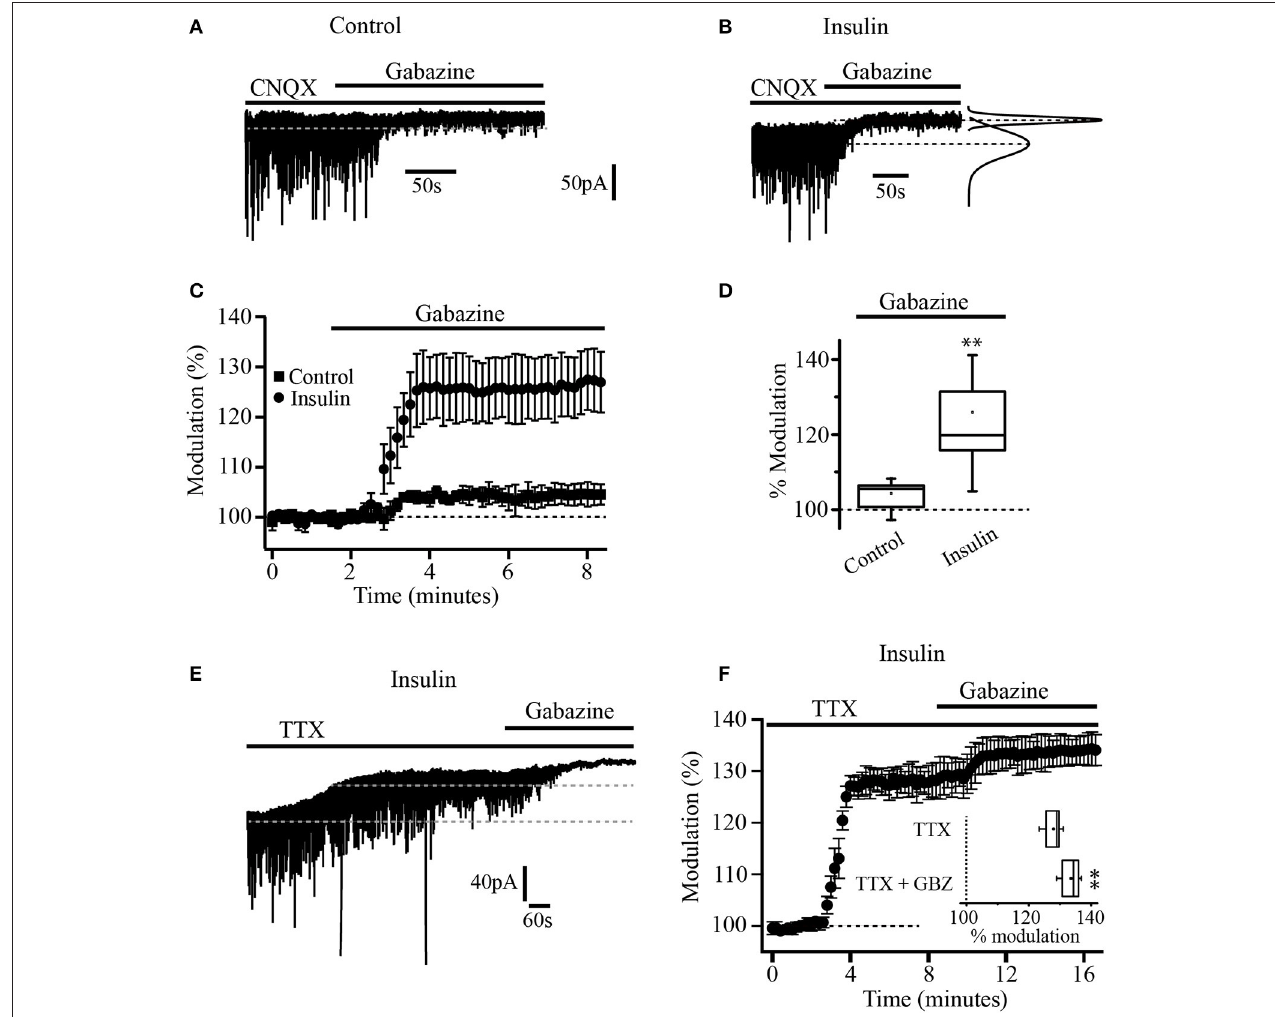
FIGURE 1 | Insulin increases tonic current in PFC pyramidal neurons. (A) Current recording of a single cell in control conditions (without insulin). Black bars over the recording indicates the time application of CNQX (50 µ M) and gabazine (SR-95531, 20 µ M). Gabazine inhibits IPSCs and causes a small but significant shift of the holding current in control conditions (no insulin). ( B) Current recording of a single cell from a slice previously incubated with insulin (20nM). Gabazine blocked the IPSCs and produced a bigger shift of the holding current. At right, Gaussian fits of the histograms of 30s current segments taken from the control period and after gabazine application are shown. The Gaussian peaks are indicated by dash lines. The lower dash line corresponds to the baseline current. The upper dashed line indicates the current level after gabazine application. (C) Graph that compares the response to gabazine of cells from control slices (dark squares) with cells from insulin-incubated slices (dark circles). The response is expressed as percentage of the basal current. (D) Box plot summary comparing the gabazine modulation in control ( n = 5) and insulin conditions ( n = 7). (E) Current recording of a single cell showing the effect of TTX (500nM). Black bars over the recording indicates the time application of TTX and gabazine. (F) Temporal course of the effect of TTX and TTX plus gabazine. All TTX experiments were performed in cells from slices previously incubated with insulin and in the presence of CNQX. Inset in (F) shows the box plot summary comparing the effect of TTX and TTX plus gabazine (GBZ) ( n = 5) ** p <